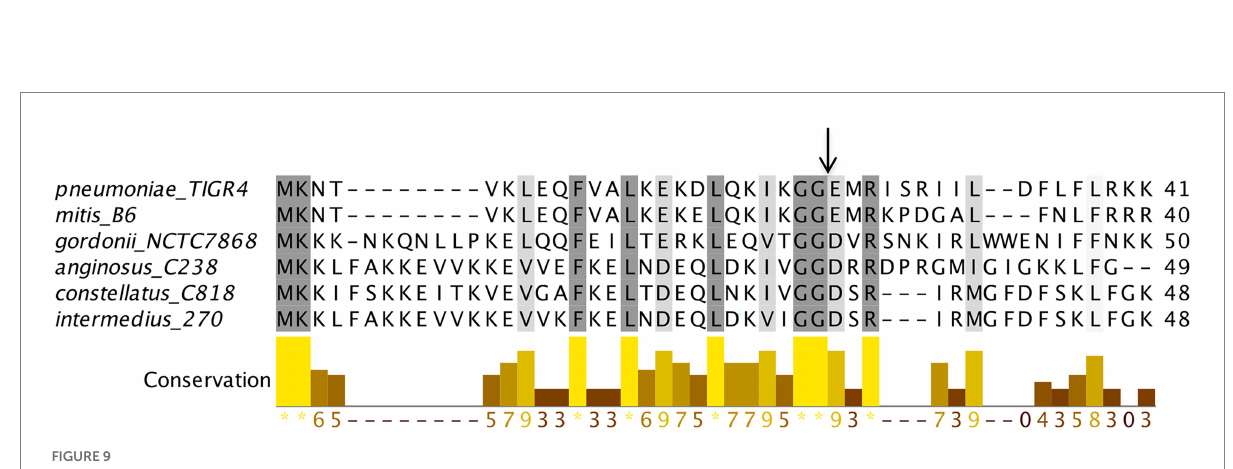
FIGURE 9 ComC polymorphism among streptococcus species. ComC homologs from representative streptococcal species were used for multiple sequence alignment. Note that for some species, matured ComC sequences show high